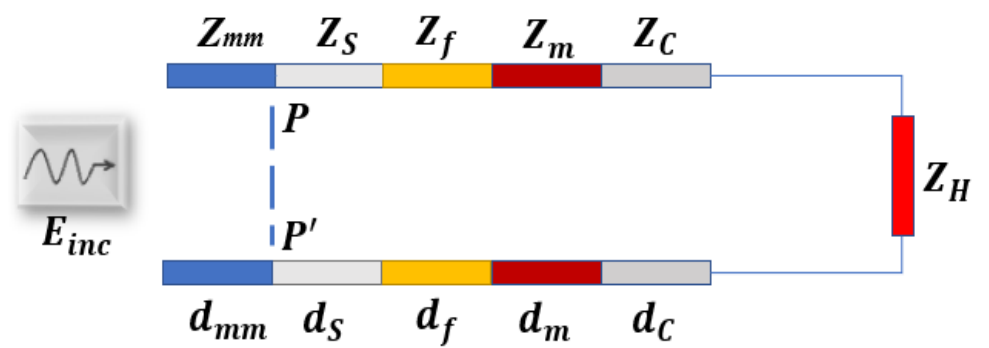
Figure 3. The transmission line model of 1-D thorax structure. The Z mm , Z s , Z f , Z m , Z C , and Z H represent the impedance of matching medium, plane PP (cid:48) , skin, fat, muscle, cartilage, and heart respectively. The different colours of the layers are chosen to distinguish between the considered tissues. Table 1. Cole-Cole parameters of skin, fat, muscle, cartilage, and heart.